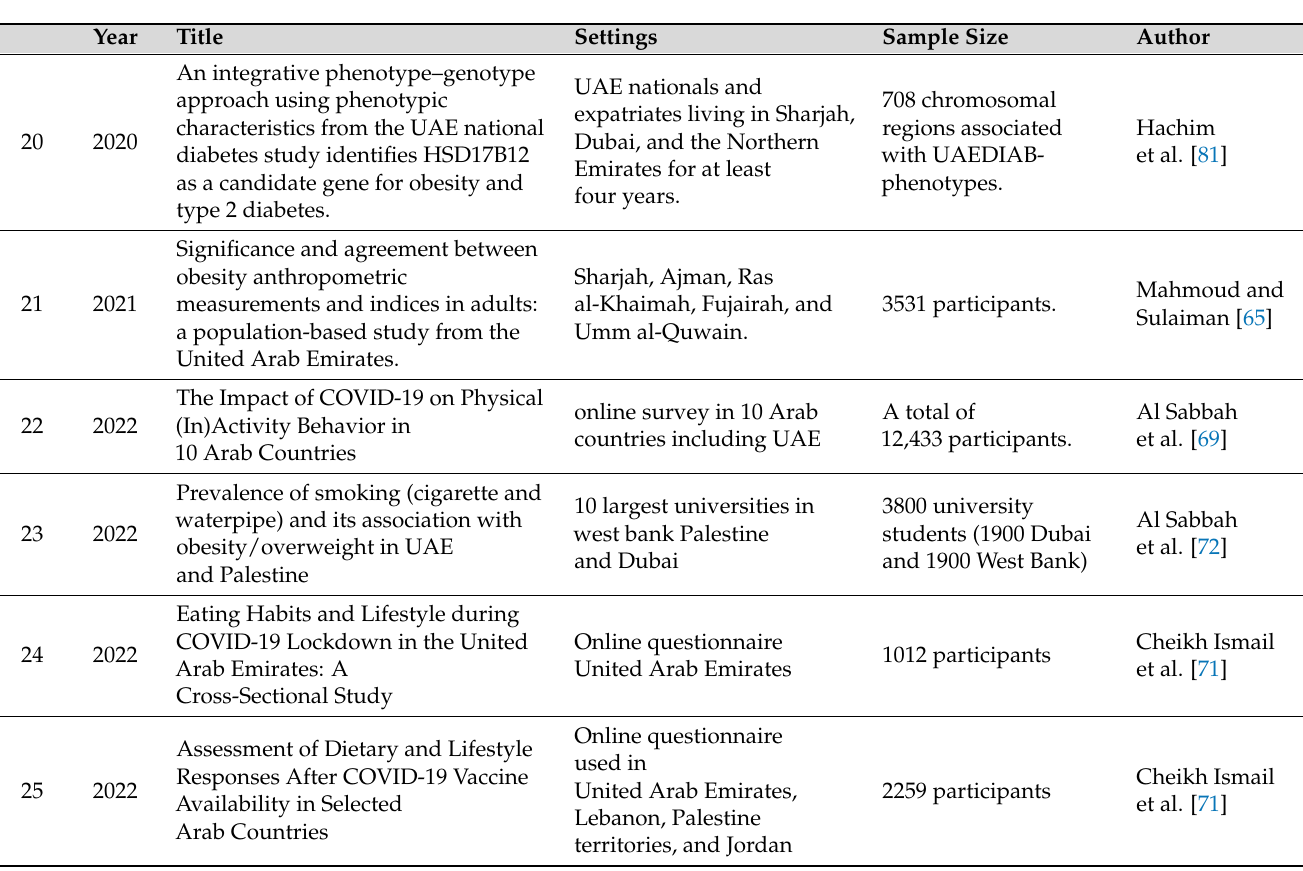
Figures 5 and 6 show the prevalence of overweight and obesity among adults in the UAE from 1999 to 2017, according to the UAE country profile, while Figure 7 shows data from 2017 to 2018, according to the UAE Ministry of Health. These figures clearly show the increase in overweight and obesity over the years.